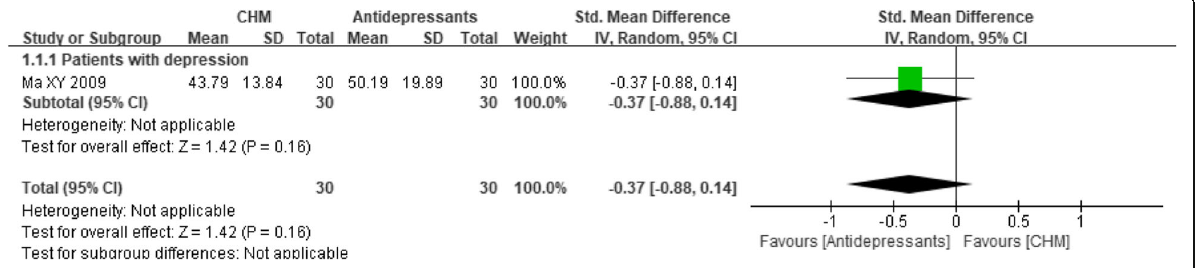
Fig. 12 Forest plot of the group mean quality of life scores for CHM versus